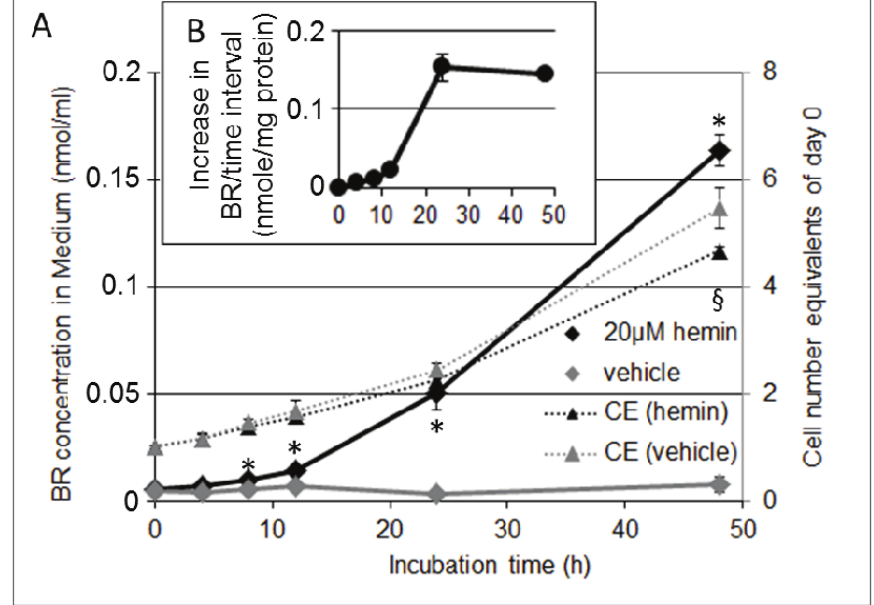
Figure 6. Production of BR by liver cells (BRL3A) as a function of the incubation time. ( A ) Cells were treated with vehicle (DMSO, grey symbols) or hemin (20 μM, black symbols) for the indicated time. BR was extracted from medium (diamonds; solid lines). Underlying cell number equivalents (CE, inset Y-axis) were determined (triangles) using crystal violet assay and expressed relative to the values of day 0 (dotted lines). After 48 h, equivalents of hemin-treated cells were significantly lower compared to the vehicle-control (§); ( B ) Hemin treatment increased the total amount of BR that was newly formed (nmole) per time interval when calculated per mg cell protein. Protein content of cell samples was determined at 48 h using the Bradford method and extrapolated from cell equivalents for each time